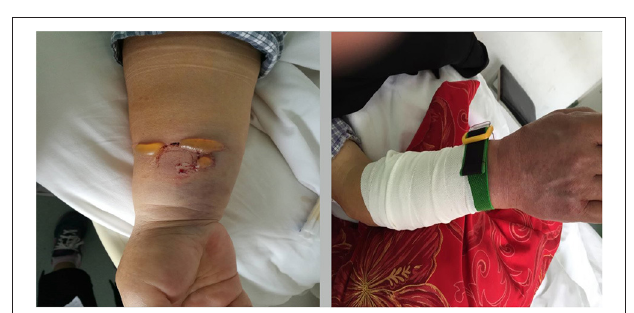
FIGURE 2 | Moderate hematoma.